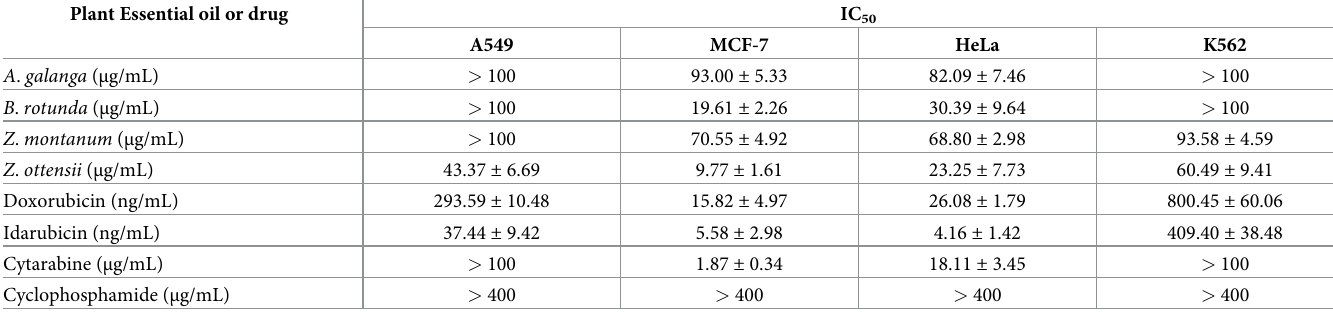
Table 4. Cytotoxicity of the essential oils and drugs against four cancer cells by MTT test. Plant Essential oil or